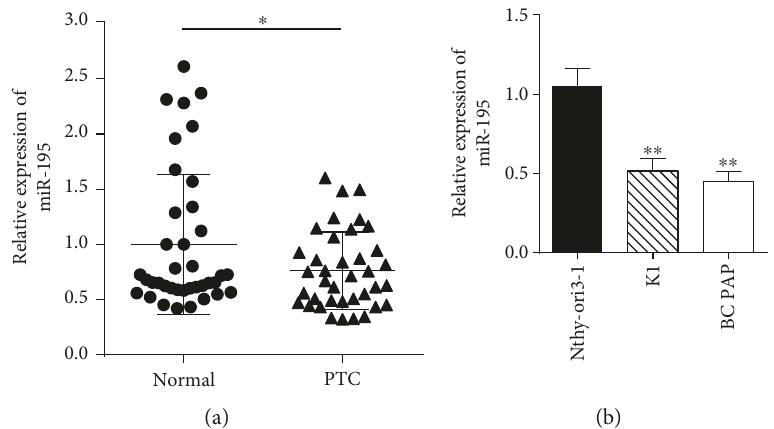
Figure 1: MiR-195 is downregulated in PTC clinical specimens and cell lines. (a) The relative expression of miR-195 in PTC tissues compared with matched adjacent normal thyroid tissues by qRT-PCR assay ( n = 38 ). (b) MiR-195 expression in normal thyroid cell line Nthy-ori 3-1 and PTC cell lines K1 and BCPAP. ∗ P < 0 05 , compared with the normal group. ∗∗ P < 0 01 , compared with Nthy-ori